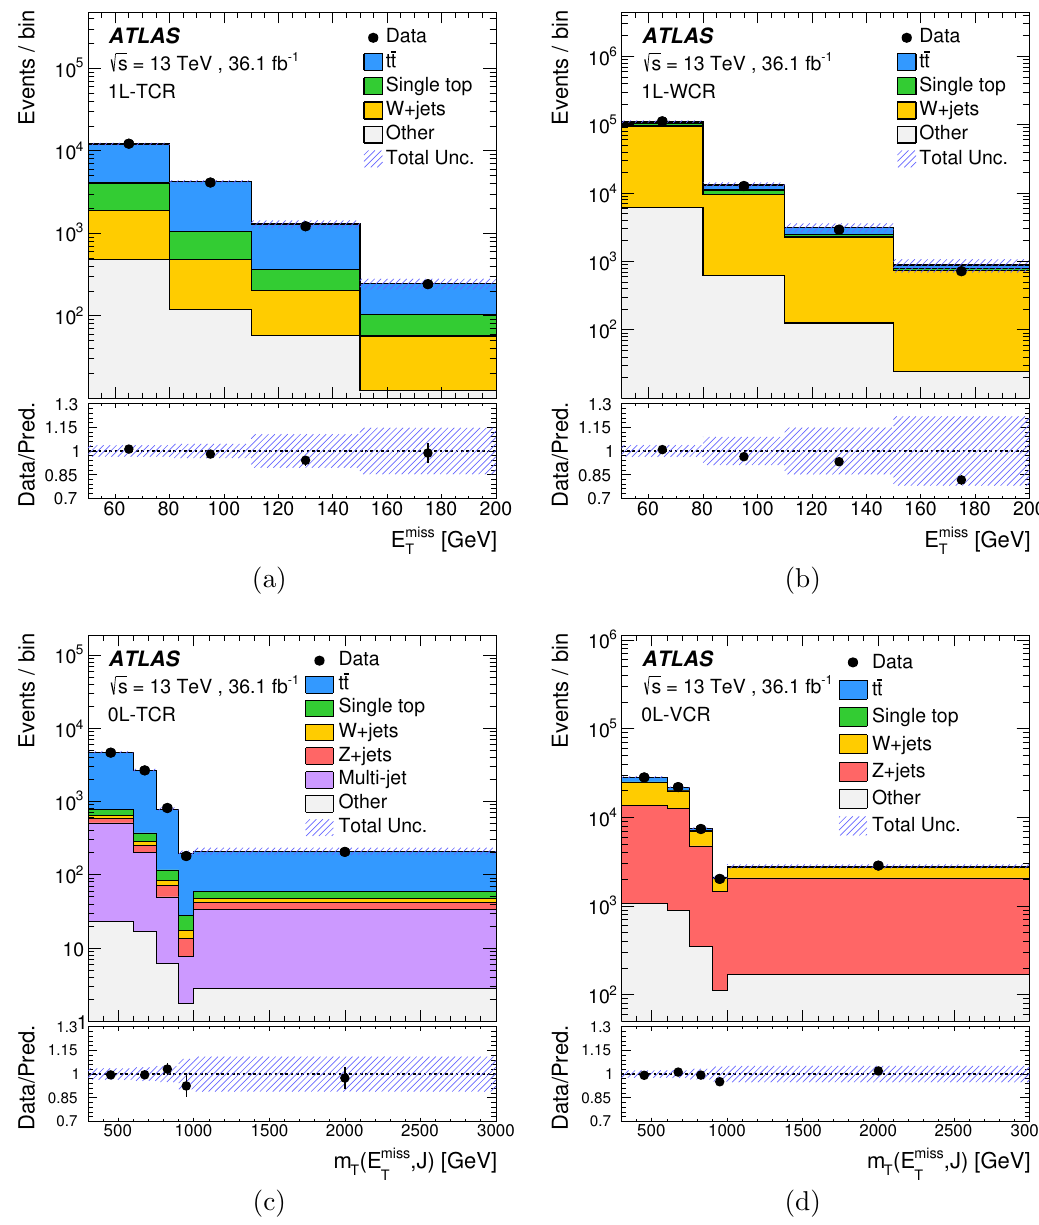
Figure 2 . Comparison of data and SM prediction for the E miss distribution in (a) the t (cid:22) t and T (b) W + jets control regions; and for the transverse mass of the top-tagged large- R jet and E miss T system, m T ( E miss ; J ), distribution in the (c) t (cid:22) t and (d) W / Z +jet control regions used for the T dark-matter search ((a) and (b)) and vector-like T -quark search ((c) and (d)). Other backgrounds in the 1L regions include multi-jet, Z +jets and diboson contributions, while in the 0L regions it is composed of diboson, t (cid:22) t + X and multi-jet contributions. The expectations in the leptonic (hadronic) channel are obtained from a (cid:12)t of the background-only hypothesis to data in the 1L (0L) control regions, where the normalisations of the t (cid:22) t and W + jets ( t (cid:22) t and W / Z + jets) processes are treated as nuisance parameters in the (cid:12)t. The error bands include statistical and systematic uncertainties. The last bin contains the over(cid:13)ow